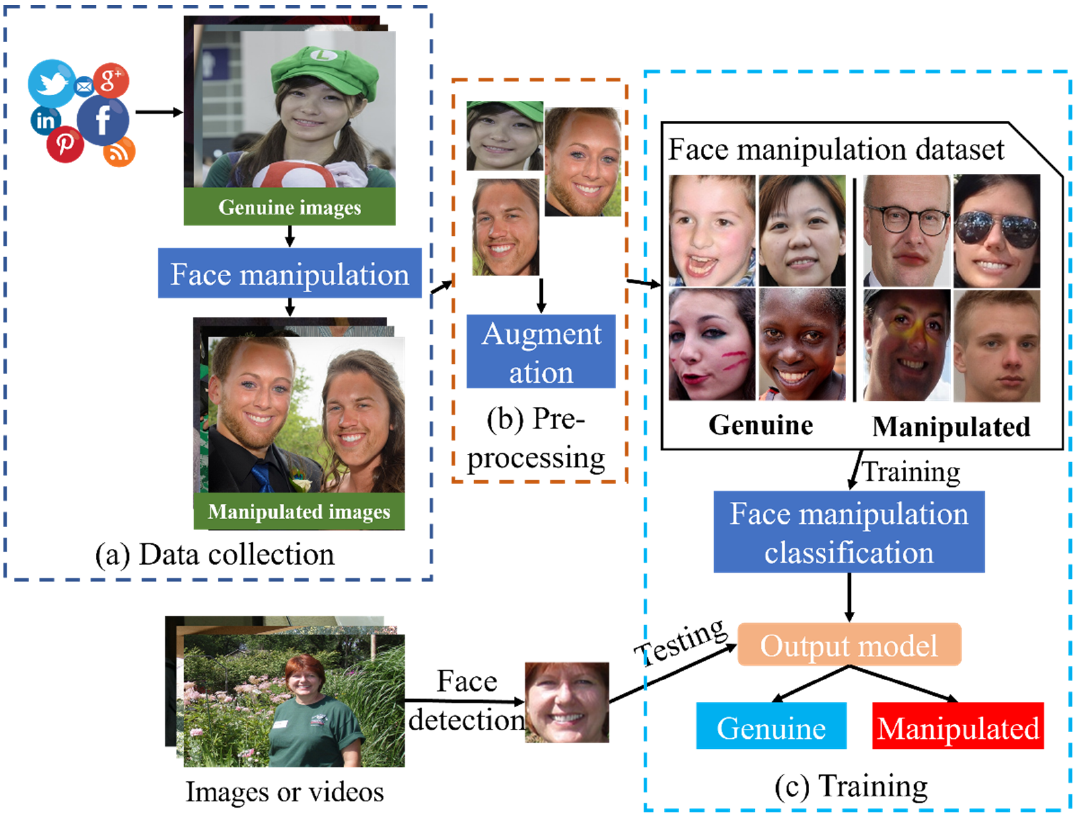
Figure 1. Overall architecture of the proposed face manipulation identification framework. Three main processes of the framework include ( a ) data collection, ( b ) preprocessing, and ( c ) training and evaluation.